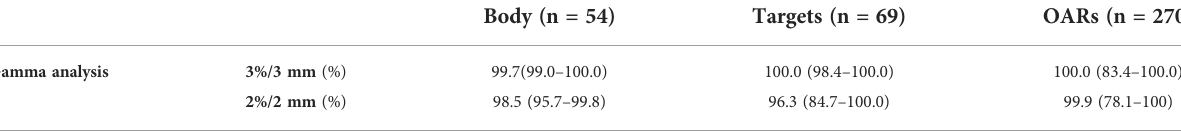
TABLE 4 Median values and range of gamma analysis results performed comparing the dose distribution on CT to syCT for 54 patients with good agreement at the fi rst check of the CT vs. syCT DVHs dosimetric parameters.